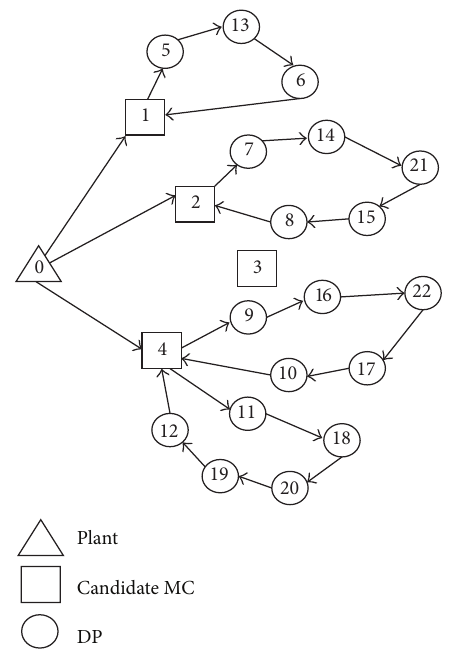
Figure 1: The specific network